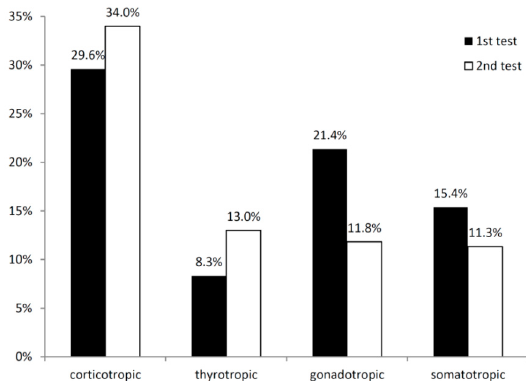
Figure 3. Pituitary insufficiencies defined by physicians’ diagnosis in the first hormonal assessment after a median of three months (first test) and the follow-up after a median of seven months (second